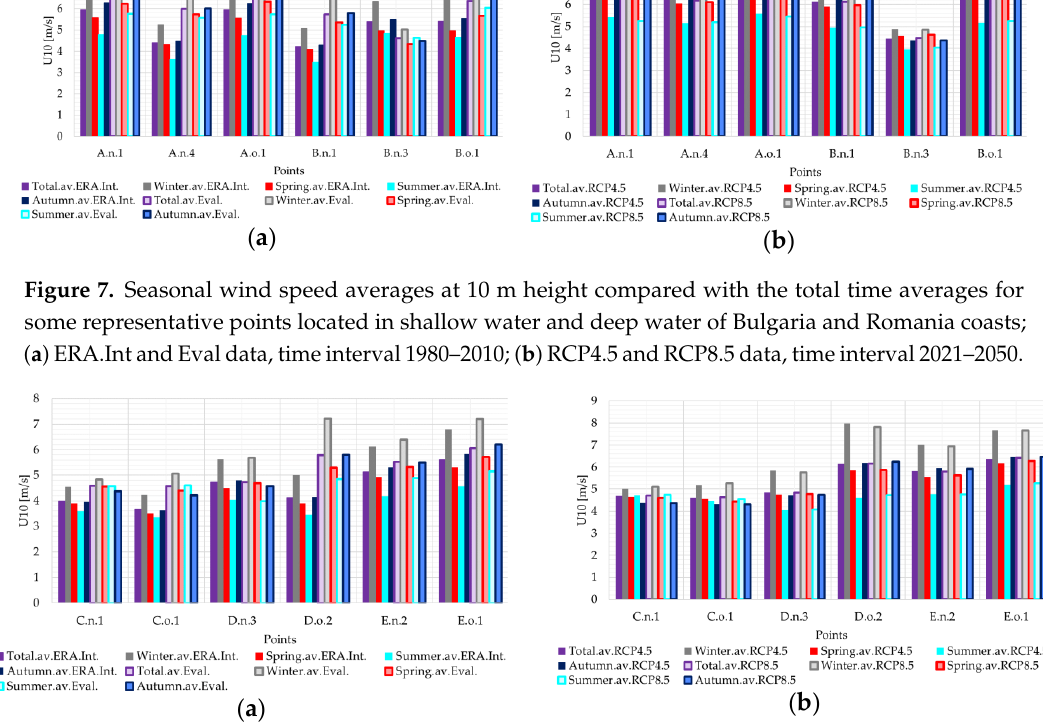
Figure 8. Seasonal wind speed averages at 10 m height compared with the total time averages for some representative points located in shallow water and deep water of Crimea Peninsula, Russia and Turkey coasts; ( a ) ERA.Int and Eval data, time interval 1981–2010; ( b ) RCP4.5 and RCP8.5 data, time interval 2021–2050.